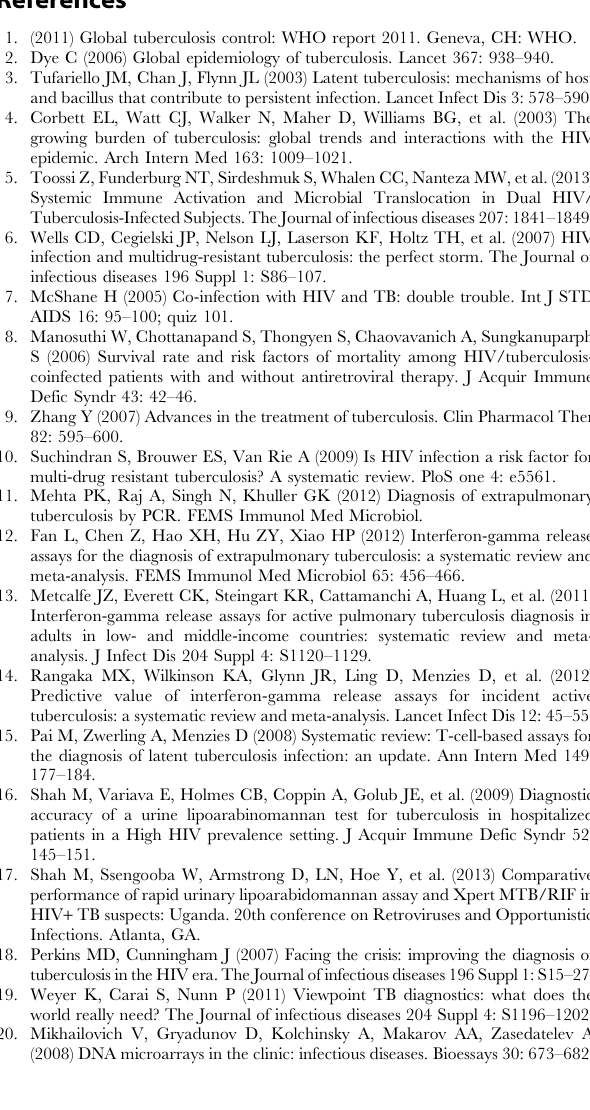
observed between samples from HIV/TB and HIV patients. The 287 genes are those that are both differentially expressed and methylated between the two patient groups. White bars represent genes that are more methylated in HIV/TB than in HIV. Grey bars represent genes that are less methylated in HIV/TB than in HIV. (TIF) Table S1 List of the 251 gene TB-signature identified using SVM-RFE. Genes are listed according to SVM